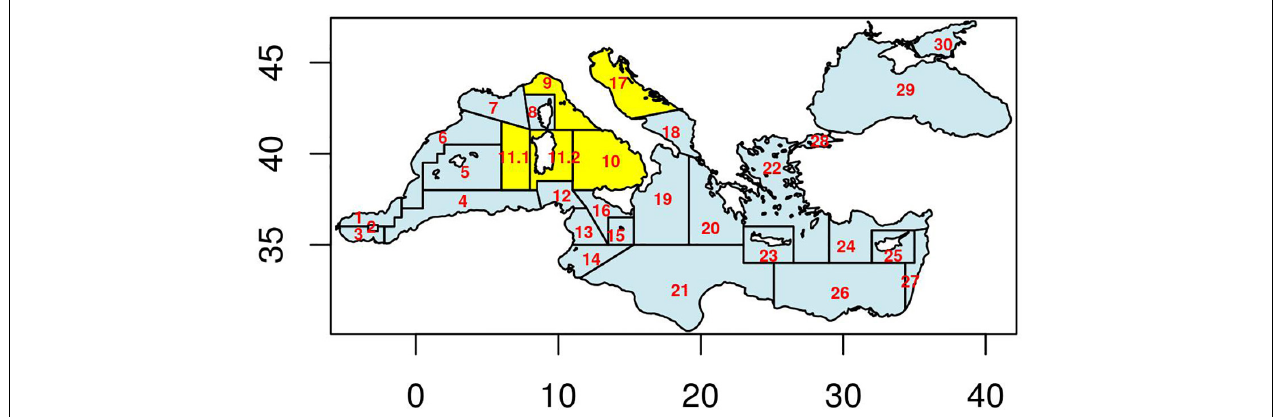
FIGURE 1 | FAO Geographical Subareas (GSAs) in the Mediterranean and Black Sea. Highlighted in yellow are the areas covered in the analysis of the seven stock assessment case studies. Vertical axis is Latitude and horizontal one is